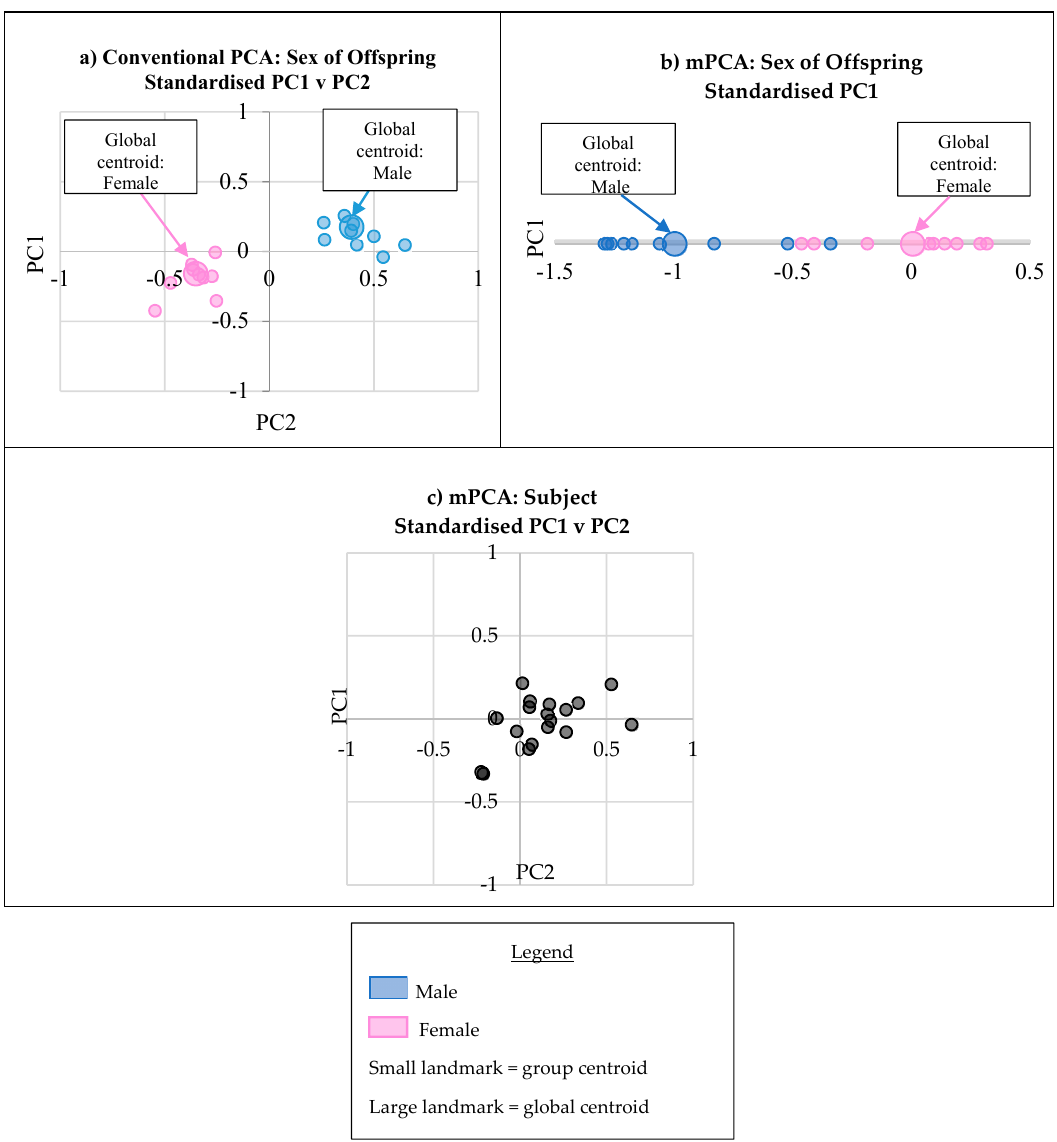
Figure 5. Scatter plots of the standardised component scores at PC1 and PC2 for conventional PCA ( a ), PC1 for sex level mPCA ( b ) and PC1 and PC2 for subject level mPCA ( c ). Clear separation of the group means of the biological sexes is evident for both conventional PCA and mPCA. At a subject level, the centroids seem to be centred around the origin, although there is some deviation from this, perhaps due to group sample sizes.